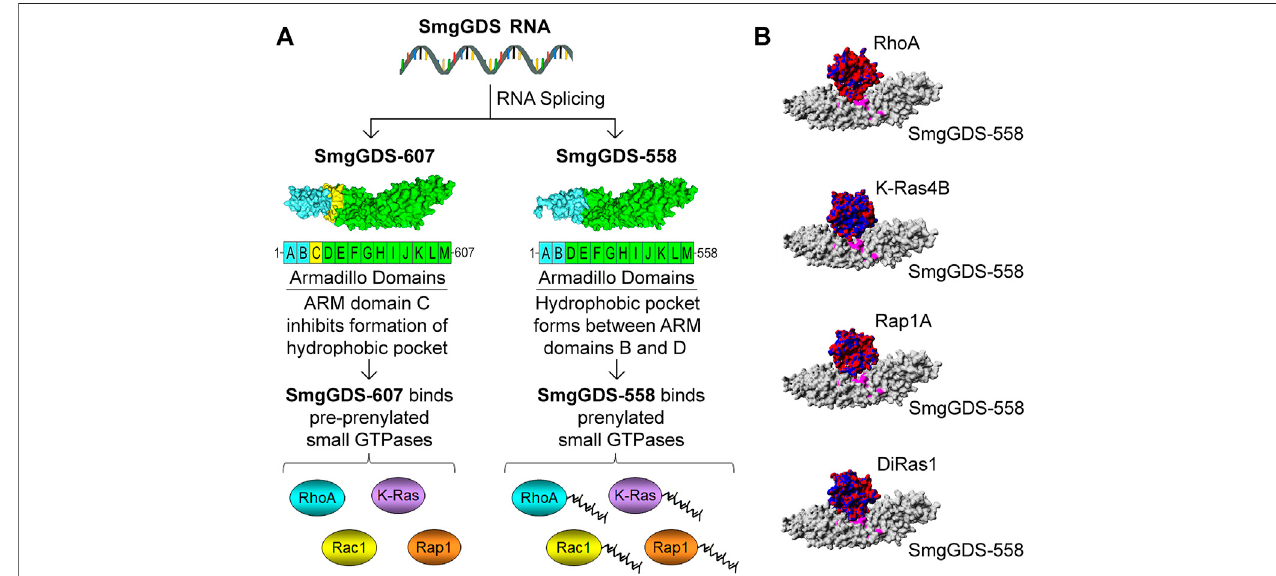
FIGURE1| SchematicillustrationdepictinghowtheSmgGDSsplicevariants,SmgGDS-607andSmgGDS-558,interactwithpre-prenylatedandprenylatedsmall GTPases,respectively. (A) SmgGDS-607has13ARMdomainsnamedA – M.SmgGDS-607bindspre-prenylatedsmallGTPasesbecausethepresenceofARMdomain Cinhibits theformationofahydrophobicpocket inSmgGDS-607.Incontrast,SmgGDS-558lacksARMdomainC,causingittohaveonly12ARMdomains. SmgGDS- 558 binds prenylated small GTPases because a hydrophobic pocket forms between ARM domains B and D, which accommodates the prenyl group of small GTPases. (B) Homology models indicate that SmgGDS-558 binds different Ras and Rho family members in a similar manner, suggesting that these small GTPases competeforbindingtoSmgGDS-558.SmgGDS-558isdepictedwithagraysurfaceplot.ThesmallGTPasesaredepictedwithanelectrostaticsurfaceplotwithnegative charges indicated by red and positive charges indicated by blue [homology models adopted from Bergom et al.